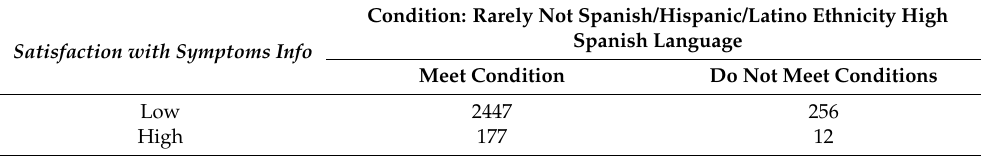
Table 14. Two by Two Table.